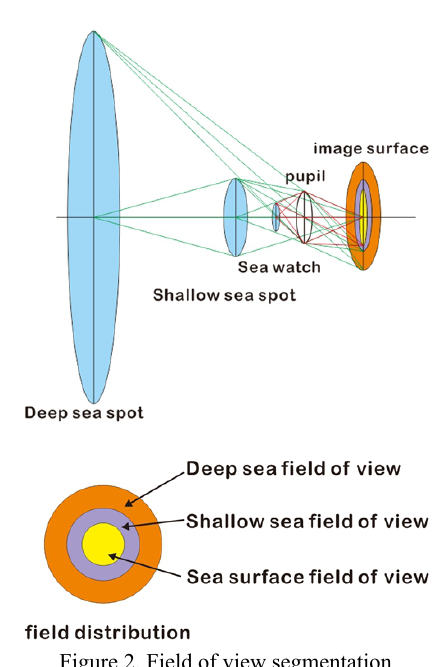
Figure 2. Field of view